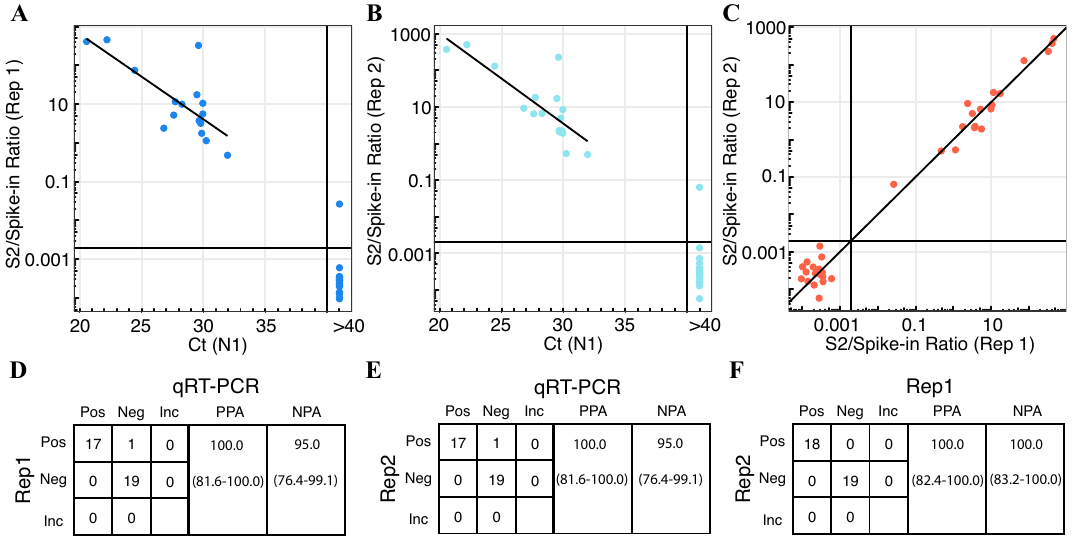
Figure 4. Swab-Seq and saline gargle for community surveillance. Saline gargle samples were obtained from 17 subjects with detectable virus (in qRT-PCR) and 20 samples with no detectable (qRT-PCR) virus. Samples were profiled in duplicate for Swab-Seq50. ( A ) Comparison of N1 qRT-PCR and S2/Spike-in ratio for replicate set 1. ( B ) Comparison of N1 qRT-PCR and S2/Spike-in ratio for replicate set 2. ( C ) Comparison of S2/Spike-in ratio for replicate set 1 with the ratio for replicate set 2. Dark vertical and horizontal lines denote the threshold for identifying positive samples in each assay (Ct < 40 for qRT-PCR, ratio > 0.002 for Swab-Seq50). The lines are least-squares fitted lines incorporating all “positive” data points for ( A ), ( B ). In ( C ), the line is the diagonal. ( D – F ) Tables of the number of samples categorized as positive or negative for the presence of the virus is presented between ( D ) replicate 1 or ( E ) replicate 2 and N1 qRT-PCR as the comparator assay, as well as ( F ) between replicate 2 and replicate 1 as the comparator. Positive (“Pos”), negative (“Neg”), and inconclusive (“Inc”) results are compared pairwise. Positive % agreement (“PPA”) and negative % agreement (“NPA”) are provided for each comparison, along with 95% confidence intervals (in parentheses) calculated with the “Wilson” method from Ref. 25